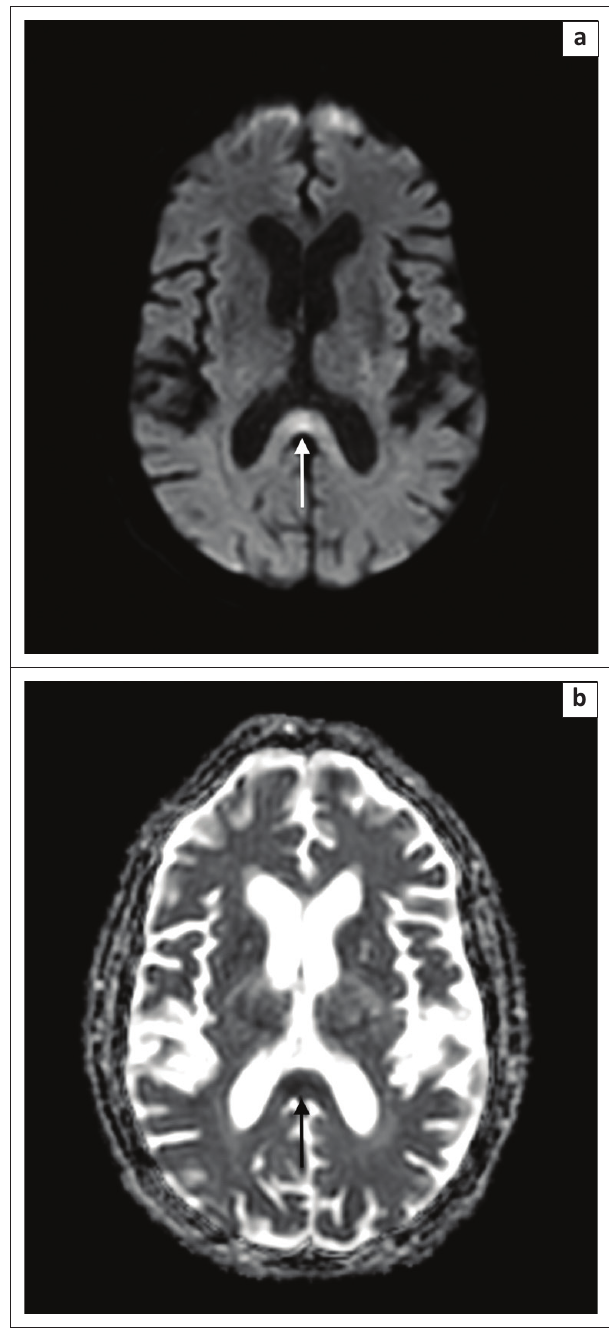
FIGURE 2: Diffusion-weigthed imaging (a) indicating increased signal in the splenium of the corpus callosum and corresponding apparent diffusion coefficient map (b) showing a decreased signal in this area in keeping with